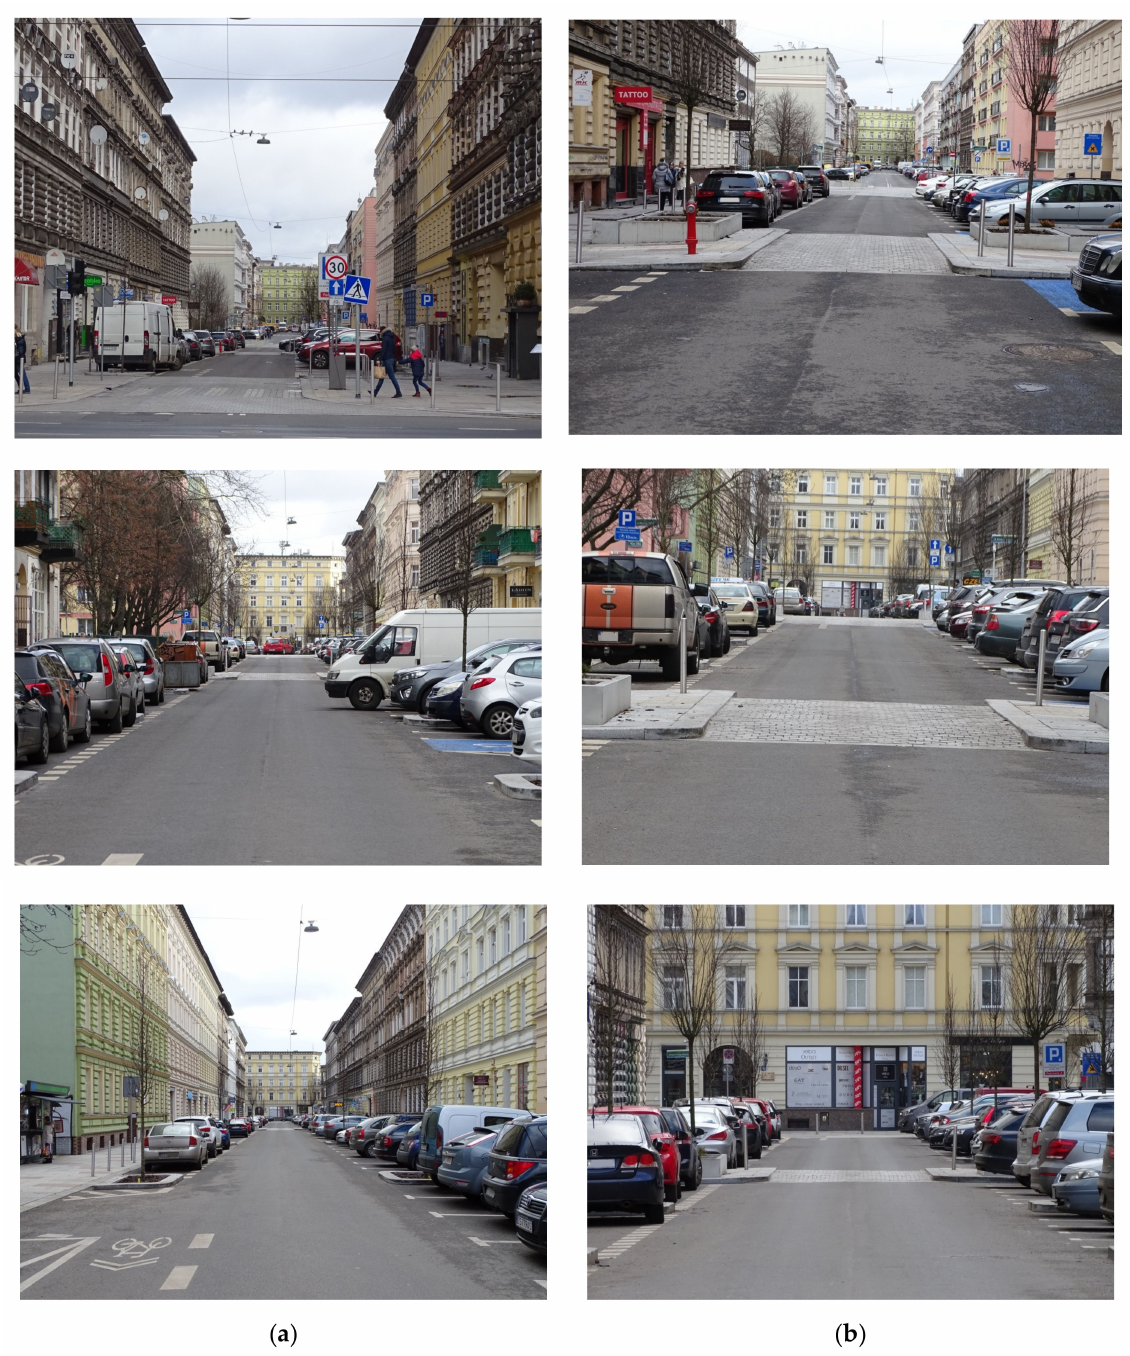
Figure 5. Test sections before and after chokers with raised pedestrian crossings in testing ground No. 1, No. 2 and No. 3: ( a ) test section before choker; ( b ) test section after choker. Source: own work of the